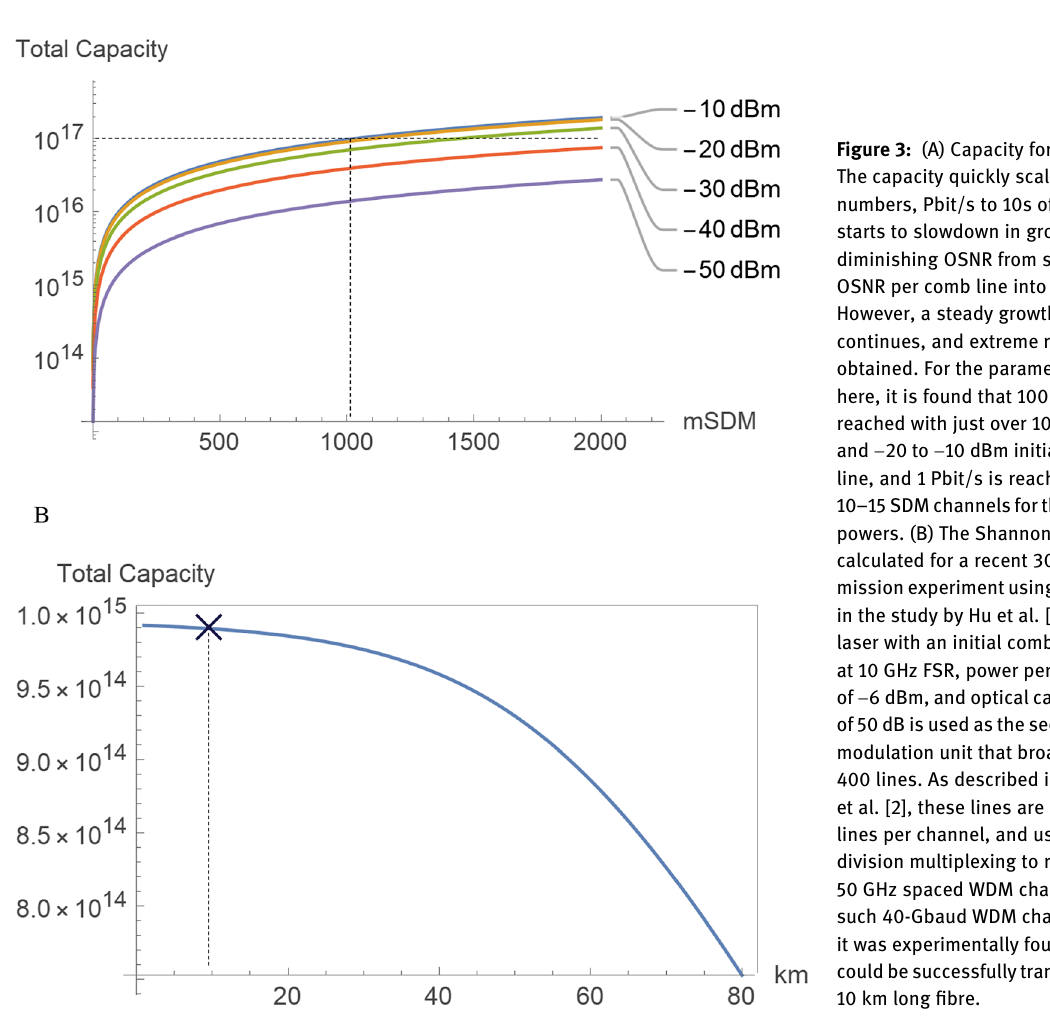
Figure 3: (A) Capacity for SDM